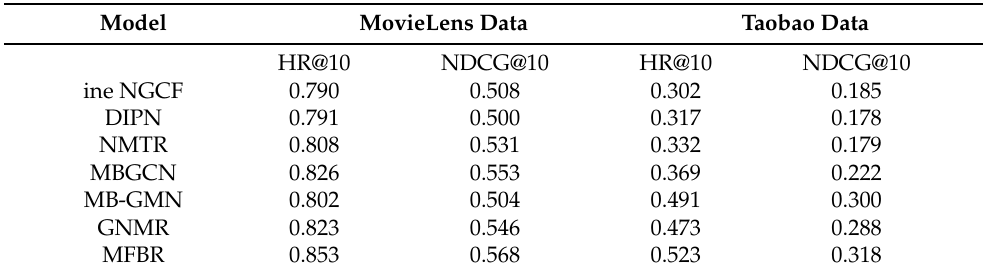
Table 2. Performance comparison.